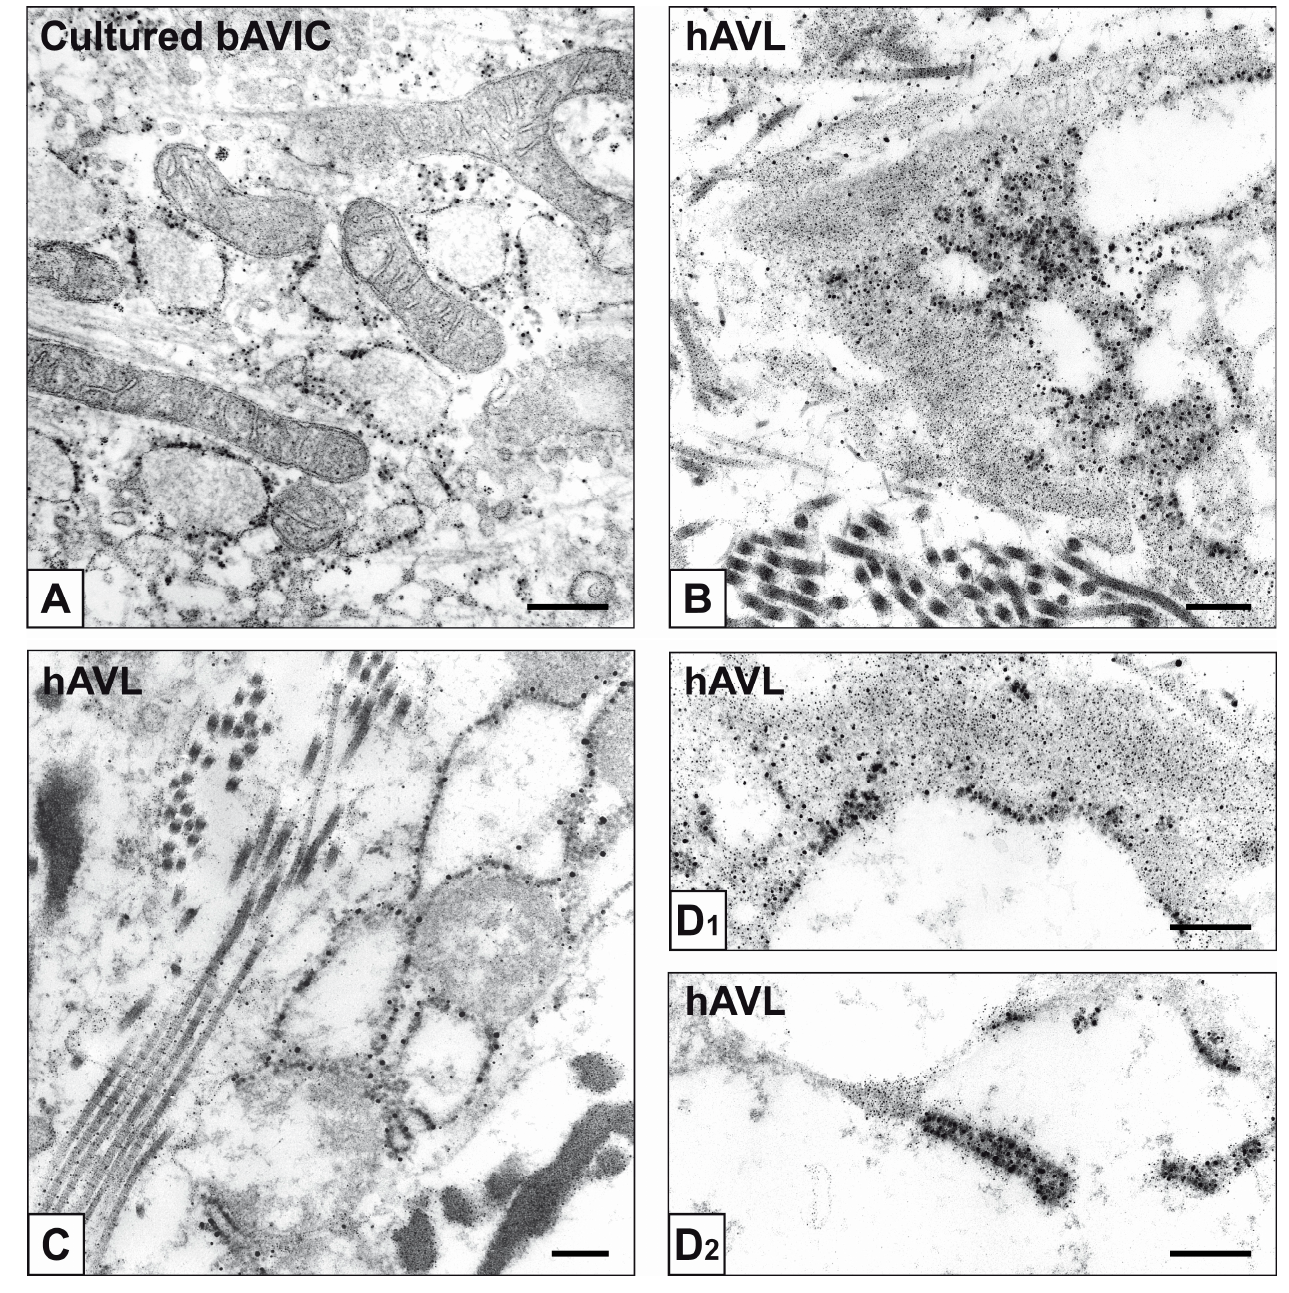
Figure 7. Post-embedding von Kossa silver staining of ribosomes in mineralizing AVICs. ( A ) Silver particle precipitation onto free ribosomes and those associated with RER membranes in a bAVIC at early calcification stages. ( B – D 2 ) Silver particle precipitation onto ribosomes associated with membranes lining enlarged RER cisternae or released nearby in hAVICs affected by ongoing calcific degeneration. Bar: 0.25 μ m.